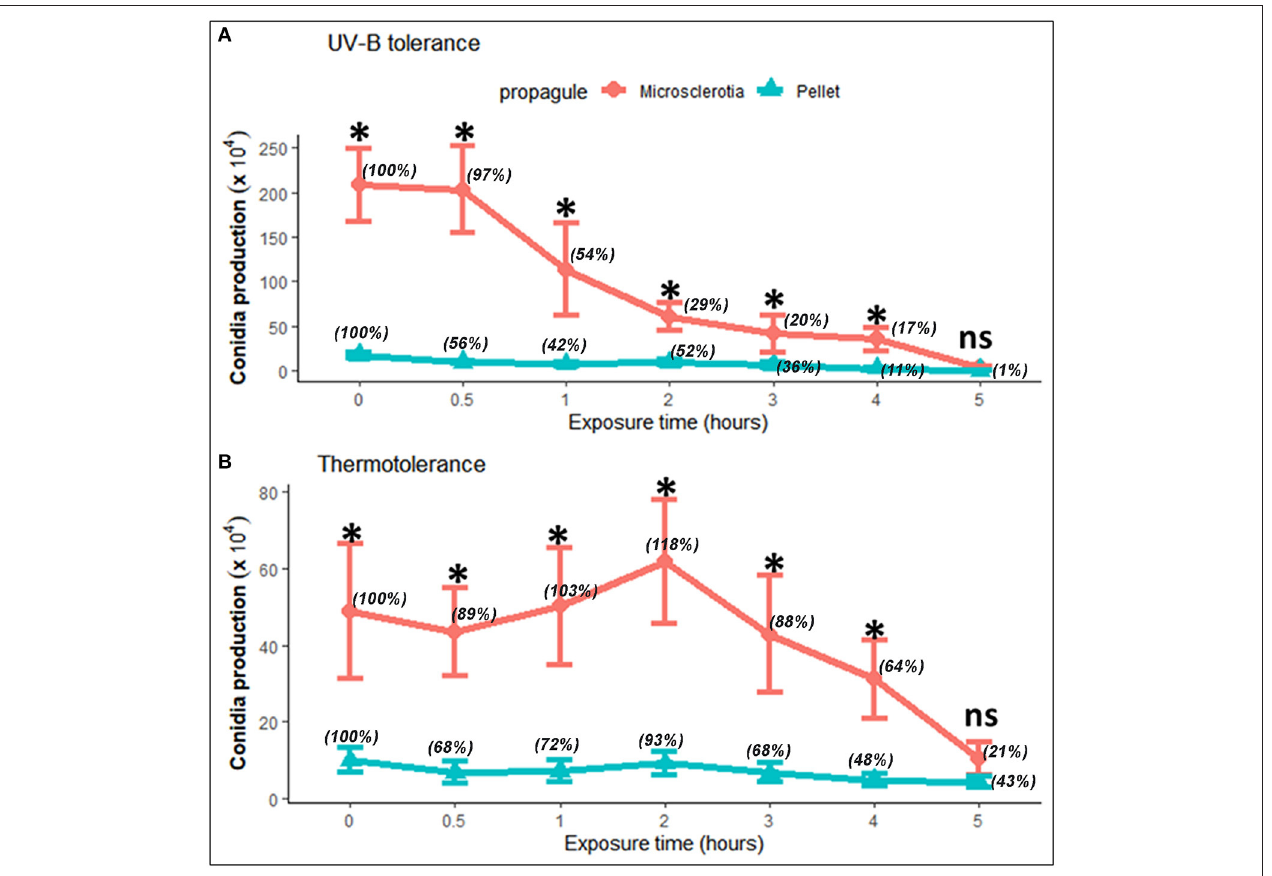
FIGURE 3 | Tolerance of microsclerotia and mycelial pellets of Metarhizium robertsii ARSEF 2575 to artificial UV-B radiation [1,283.38 mW m − 2 of Quaite-weighted irradiance ( Quaite et al., 1992) for 0 (control), 0.5, 1, 2, 3, 4, and 5h, which corresponded to the doses of 0 (control), 2.31, 4.62, 9.24, 13.86, 18.48, and 23.10 kJ m − 2 , respectively] (A) , and heat (45 ◦ C) (B) . Values indicate mean and standard error. Relative percentage values for each type of propagule are shown in parentheses. At each exposure time, the significant differences between propagules are shown with an asterisk ( p < 0.05). ns = not significant.